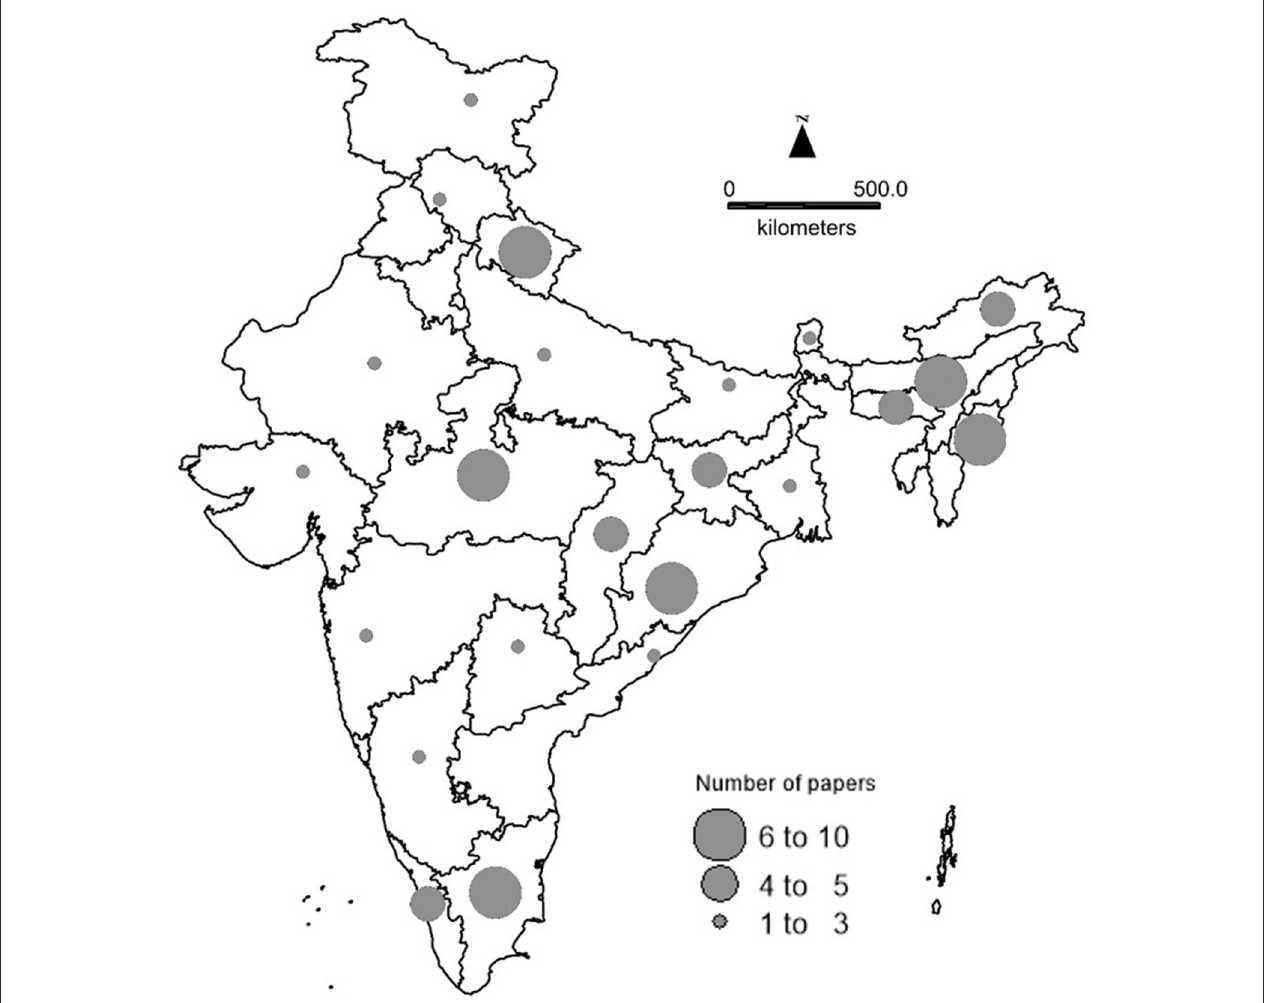
FIGURE 1 | Spatial locations of published articles considered in the current study (circle size is proportional to the number of studies reported from a